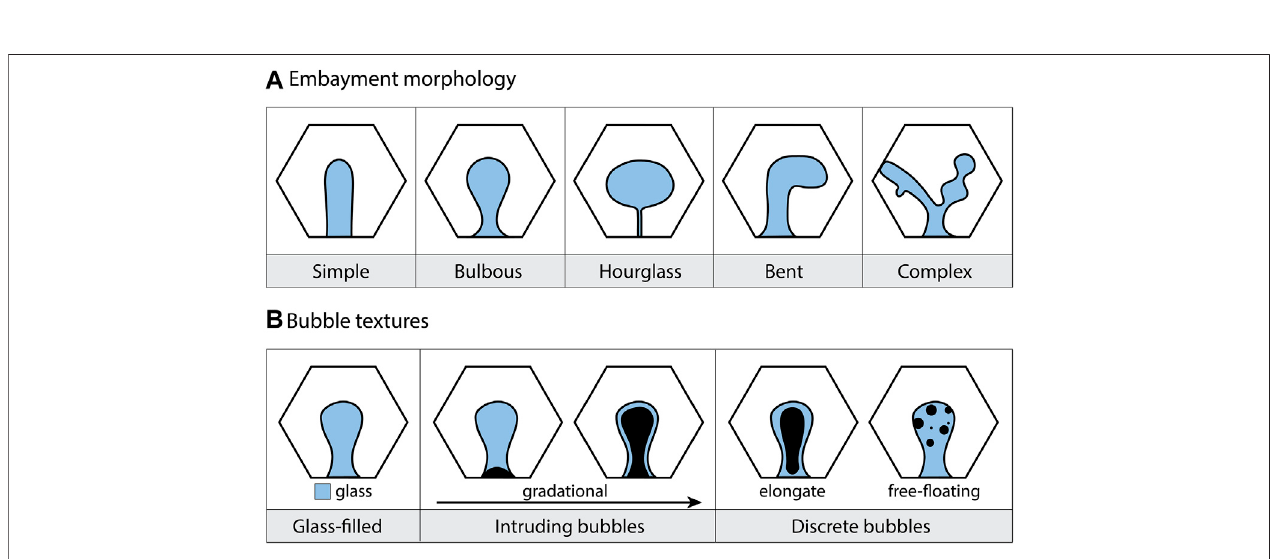
FIGURE 3 | Simpli fi ed schematic of (A) embayment morphologies, (B) idealized bubble textures, and associated naming system.